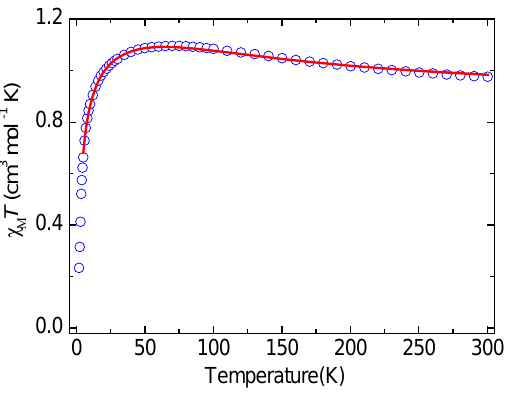
Figure 8. Plot of χ M T vs. T of Compound 2 in an applied field of 1 kOe from 2–300 K. The solid line represents the best fit.